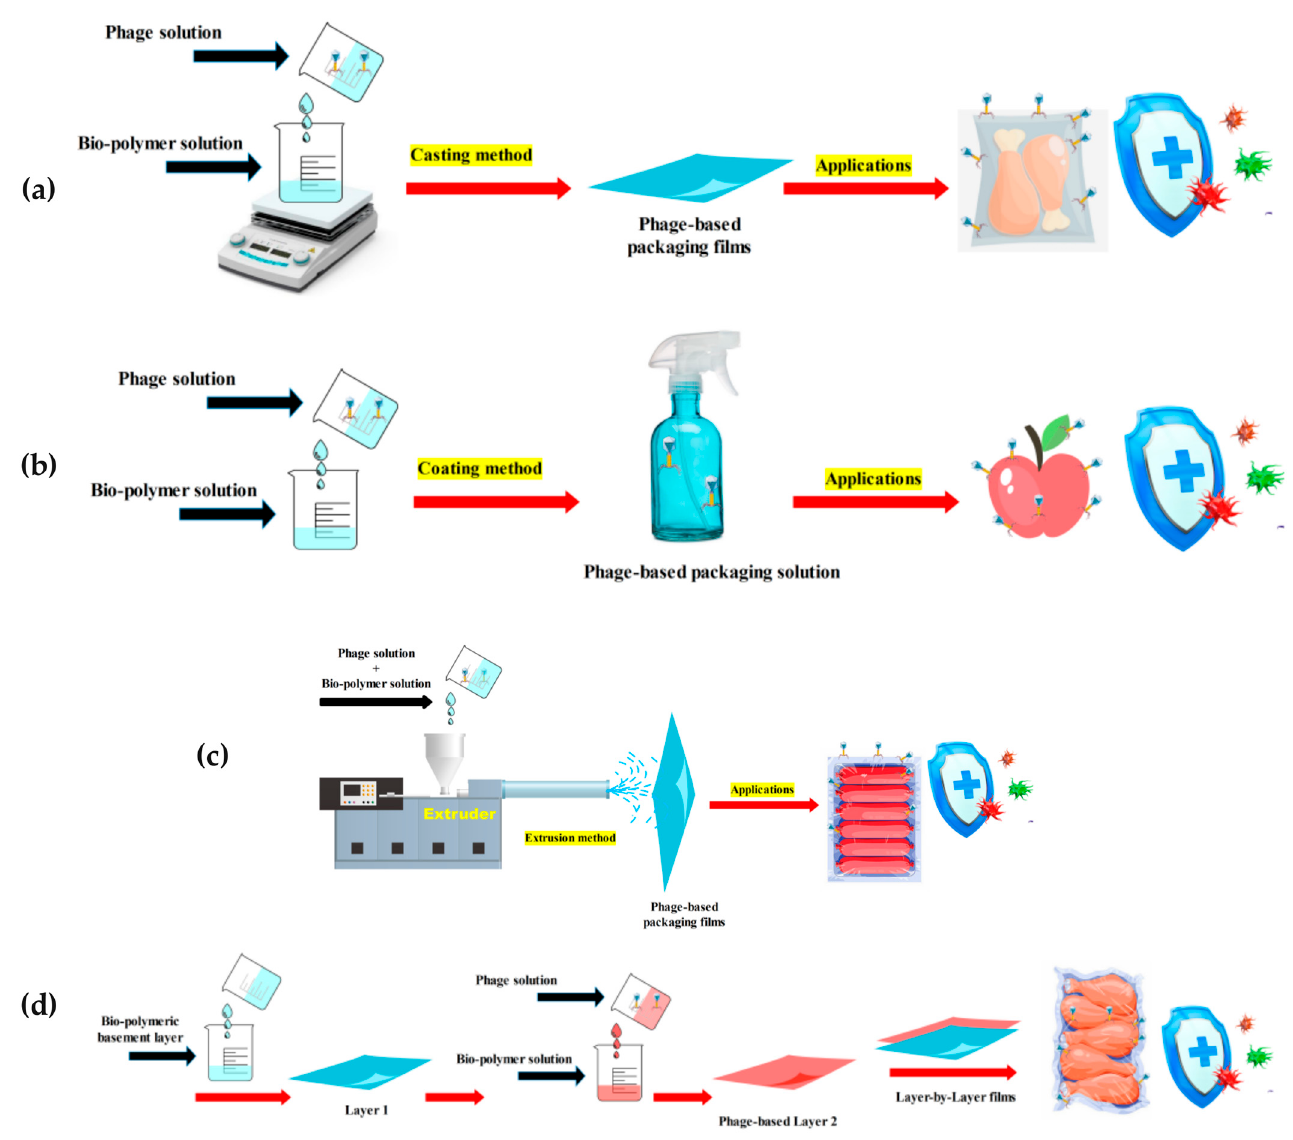
Figure 3. Techniques for fabrications of bacteriophage-based coatings/films using biopolymers ( a ) casting, ( b ) spraying, ( c ) extrusion, and ( d ) layer-to-layer.